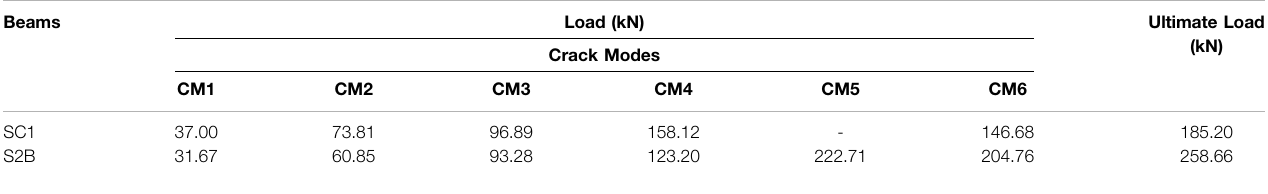
TABLE 3 | The load for each crack mode and the ultimate load for the beams.